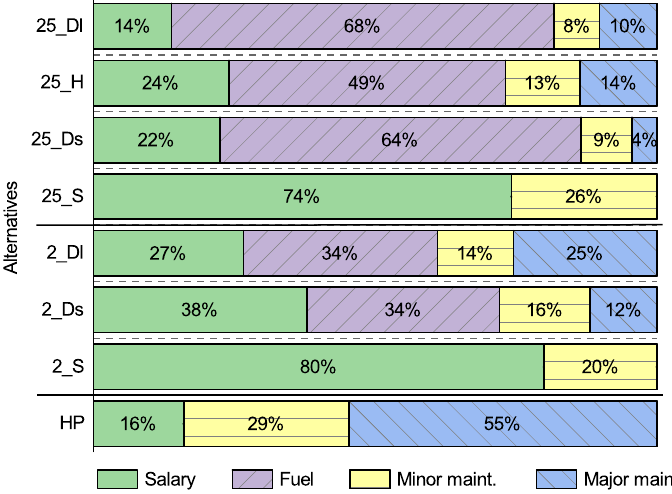
Figure 7. Contribution analysis of the OPEX costs of eight alternatives over the first 5 years of operation Supplementary Material A.20). For a list of the alternatives, see Table